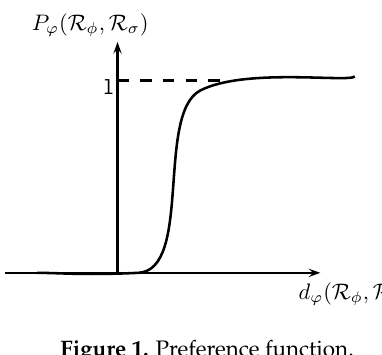
Figure 1: Preference function Figure 1. Preference